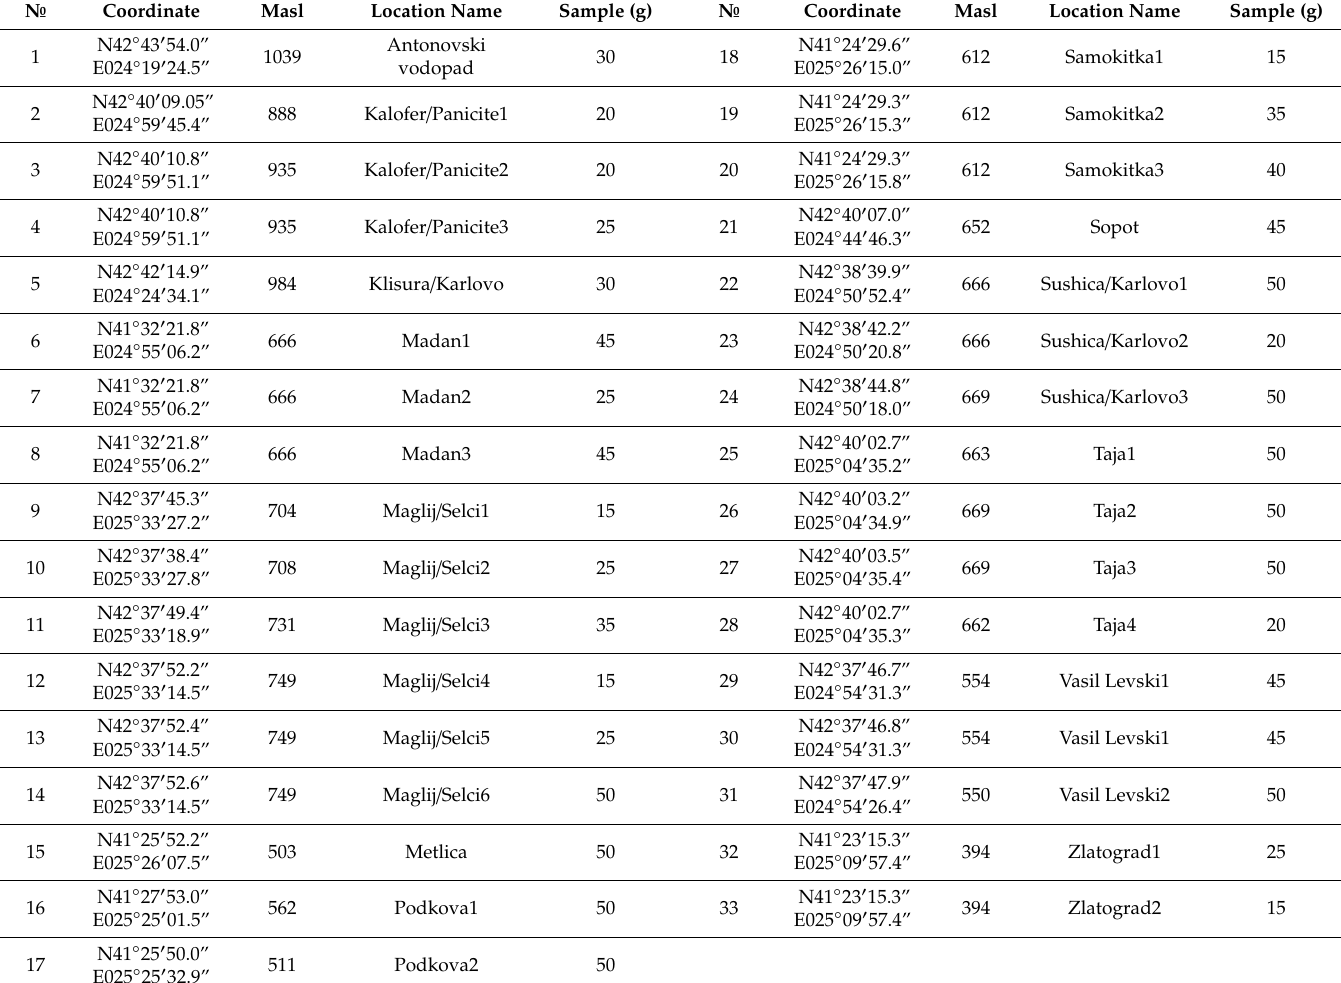
Table 5. Location coordinates, altitude (masl), and sample size (g) of Satureja pilosa in